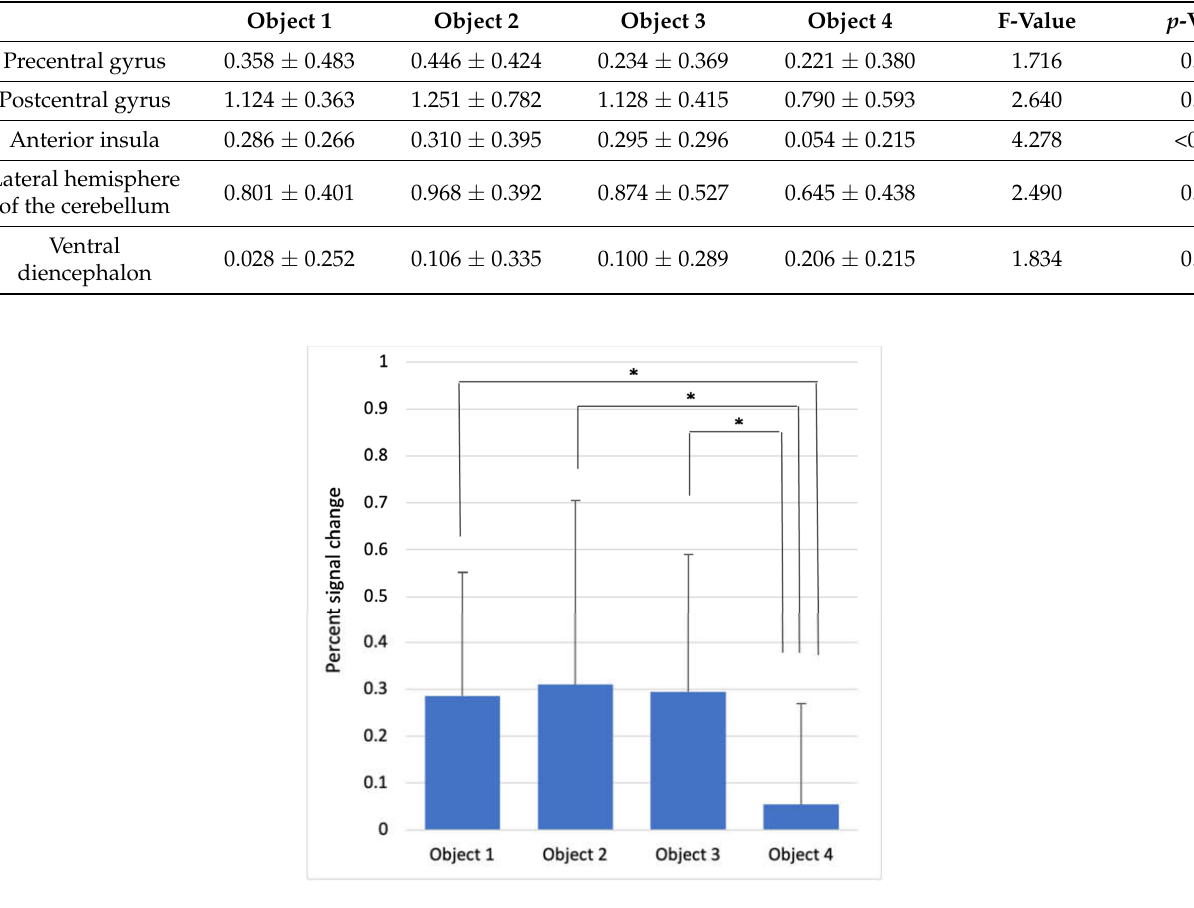
Table 3. Percent signal change in the brain areas according to each object.